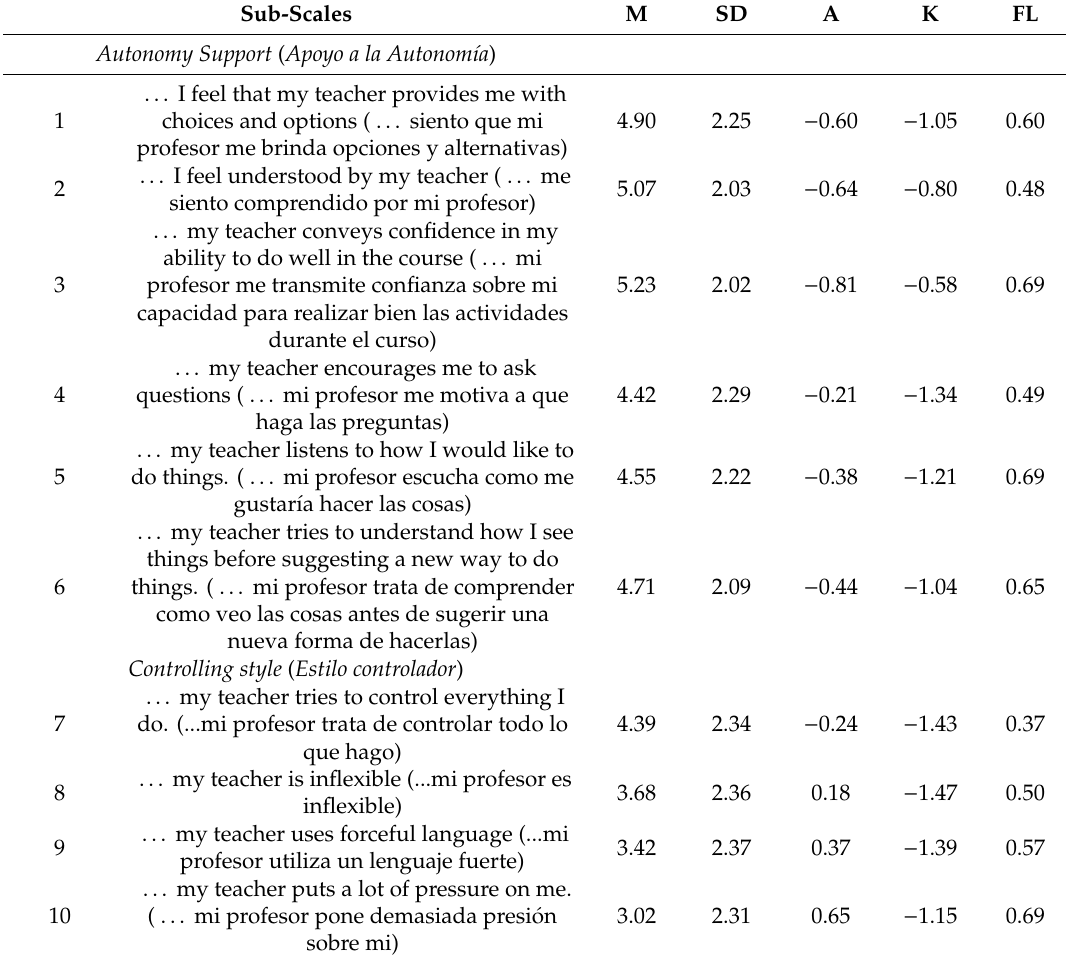
Table 1. Descriptive and standardized solution of the items and subscales of the